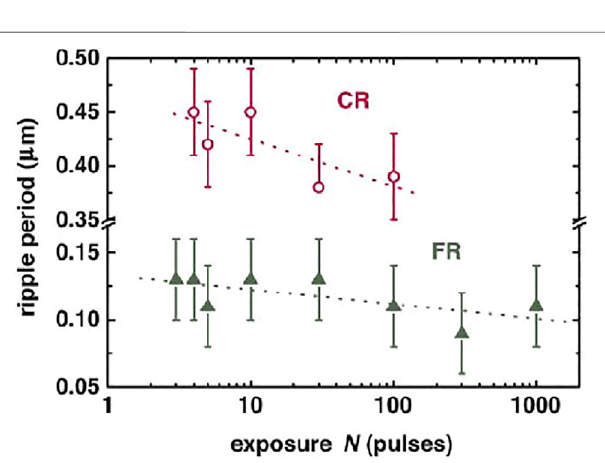
FIGURE 5 | Pulse number-dependence of the variation of CR and FR periods. The dotted lines represent qualitatively the cumulative trends [41].